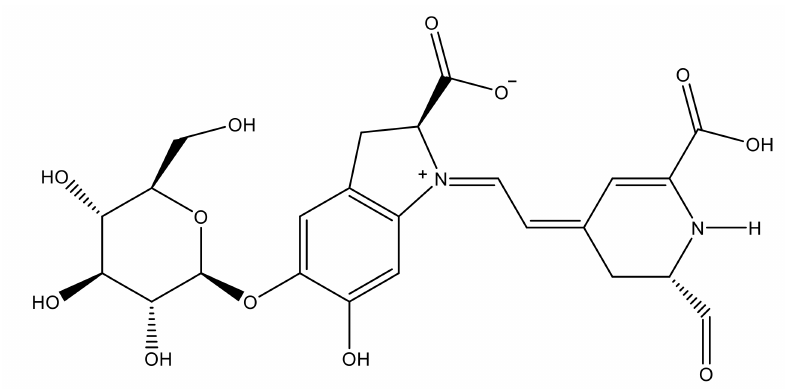
Figure 1. Structure of